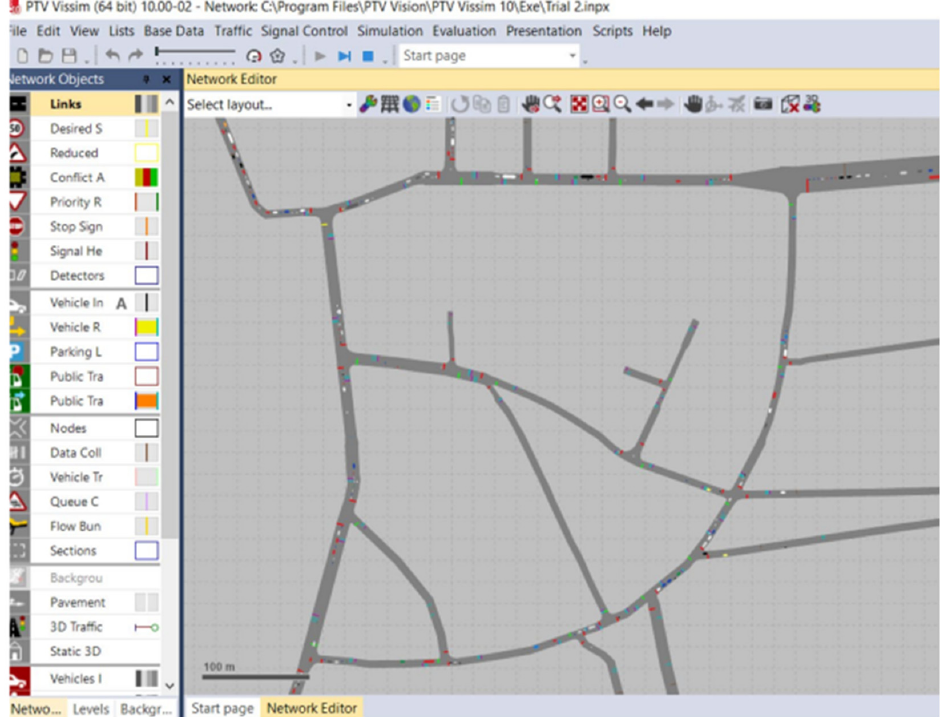
Figure 1. The material weighing and feeding of material into the